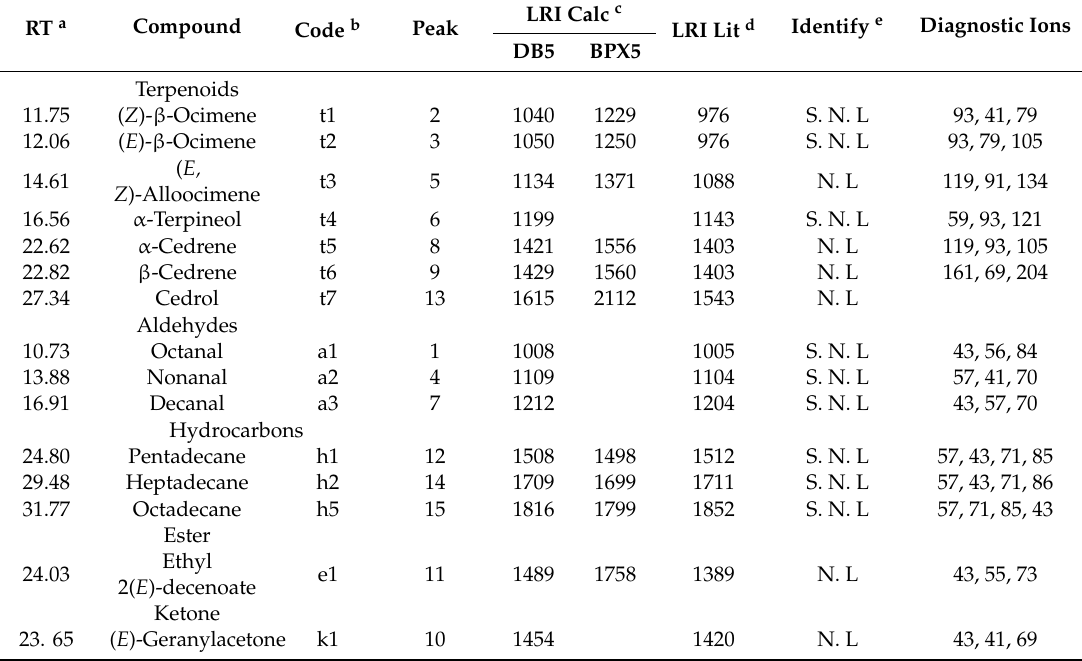
Table 1. Volatile compounds tentatively identified from larvae and larval food at di ff erent larval